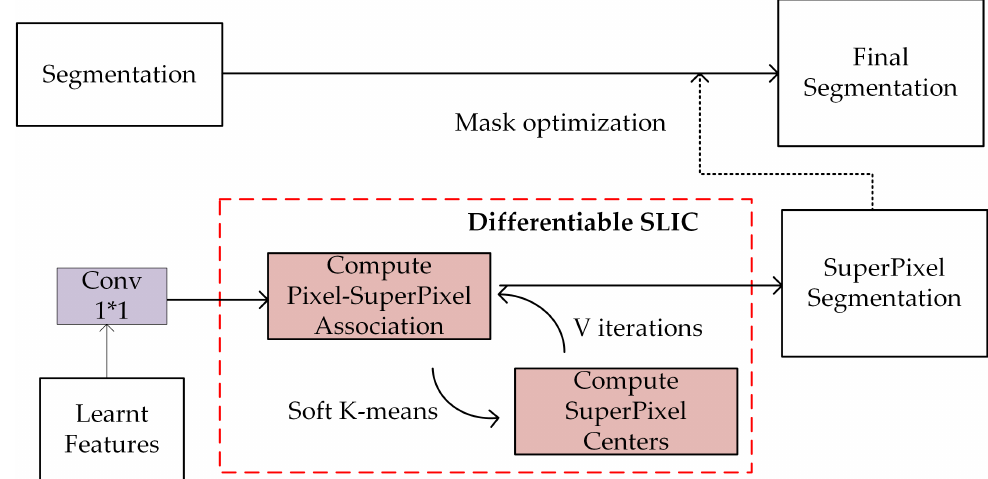
Figure 4. Superpixel optimization module. Conv in the figure represents the convolution operation using a 1 × 1 size convolution